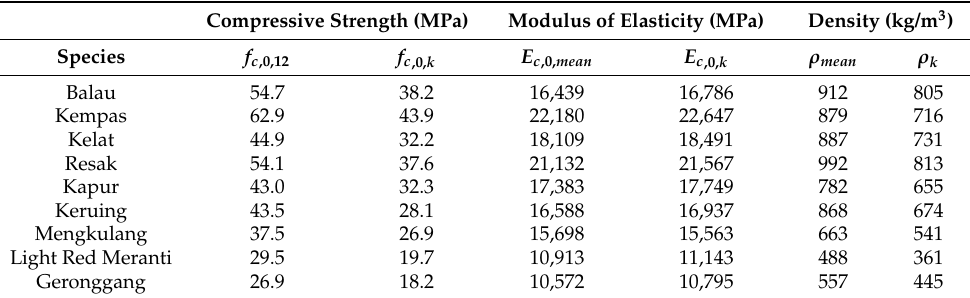
Table 3. Characteristic values of compressive strength parallel to the grain, modulus of elasticity and density for nine species of selected Malaysian Hardwood